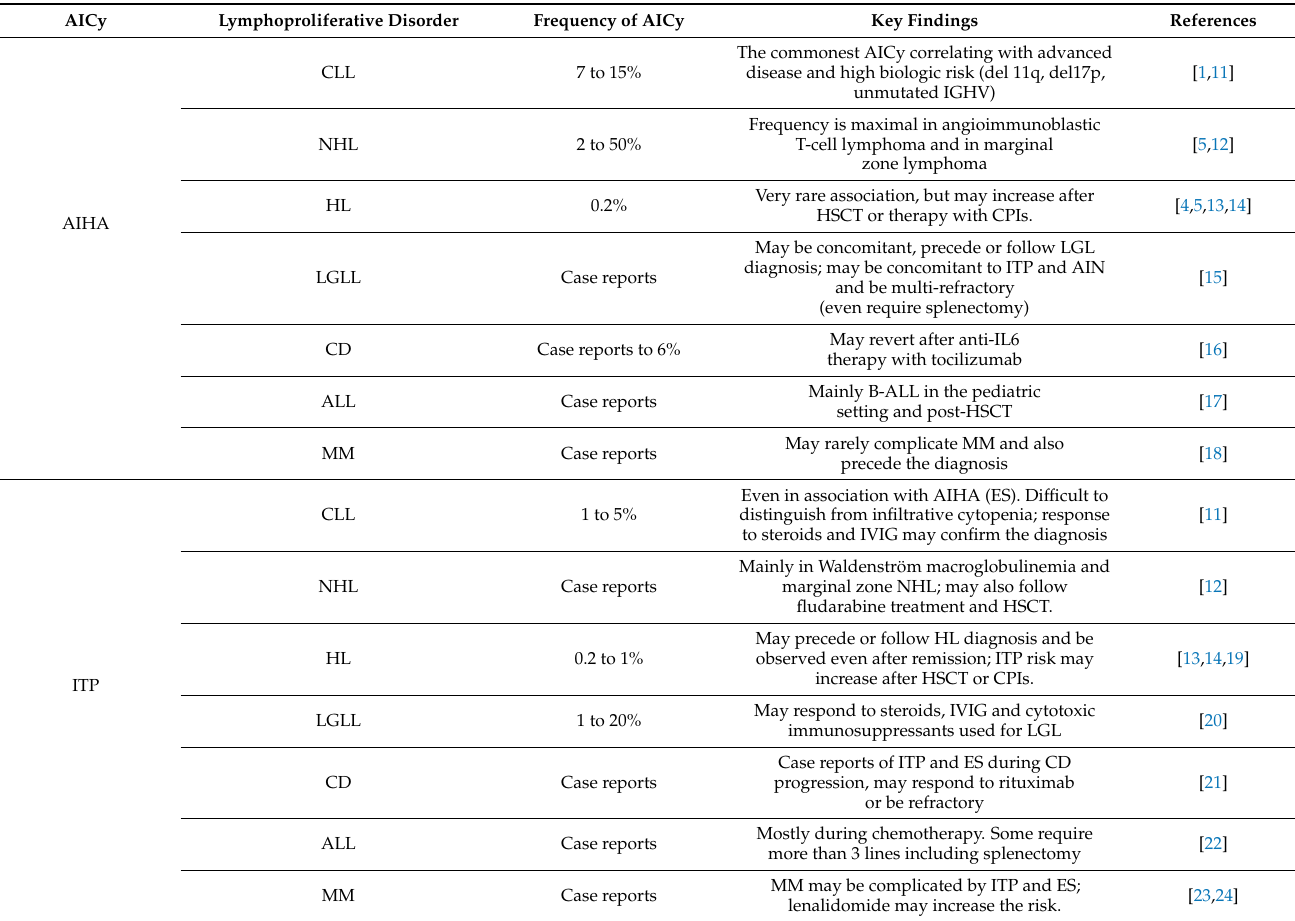
Table 1. Autoimmune cytopenias (AICy) complicating lymphoproliferative disorders. AICy Lymphoproliferative Disorder Frequency of AICy Key